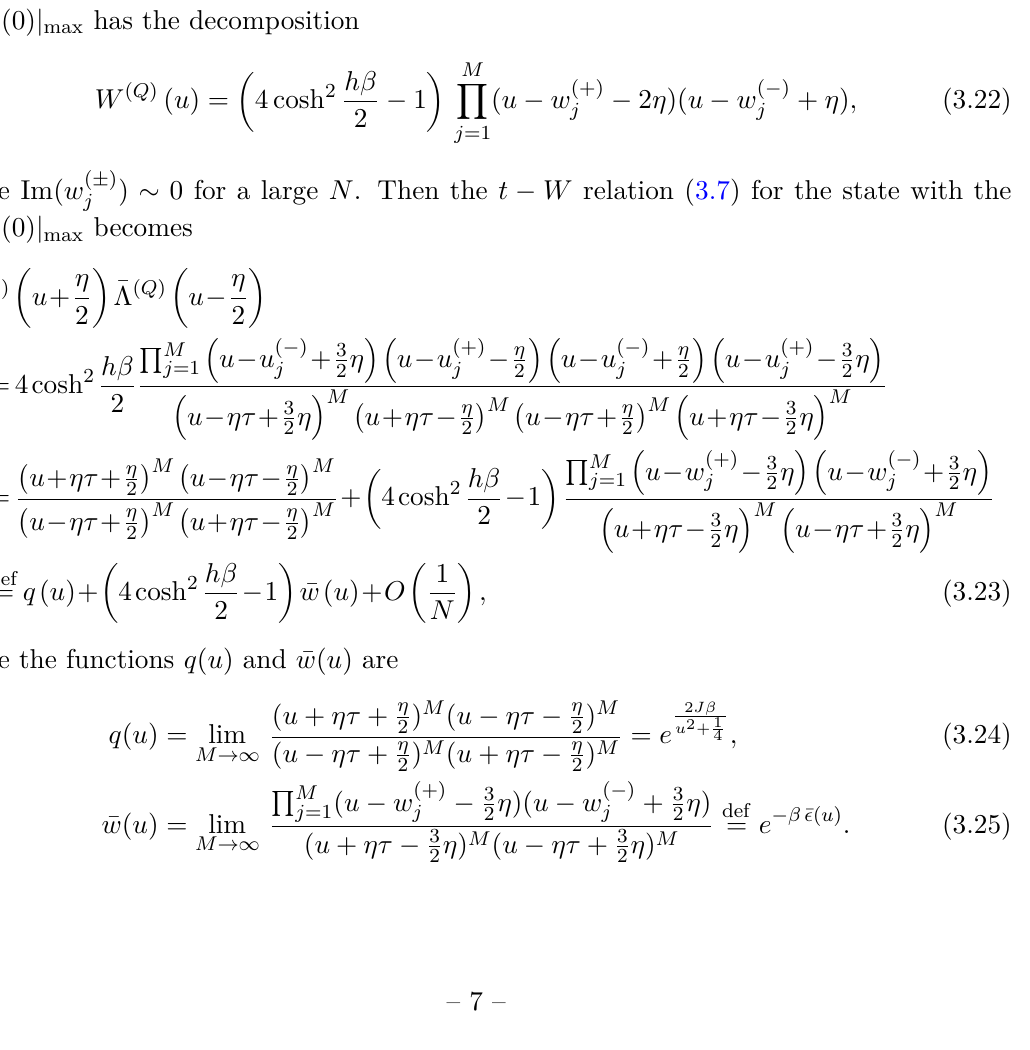
Figure 1 . (Colour online) The distributions of the Bethe roots (black ∗ ), z -roots (red M ) and w -roots (blue (cid:3) , the roots are shifted down η state with the maximus Λ ( Q ) (0) at finite temperatures T = 0 . 5 (a) and T = 5 (b). In both plots, we set N = 100